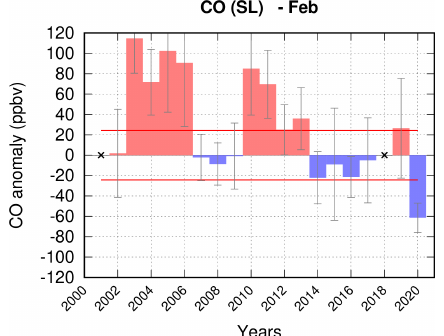
Figure B1. Anomalies of CO in the surface layer ( > 950hPa) for the month of February since 2001. The grey bars represent the 95% confidence limits, and the blue horizonal lines represent the inter- annual